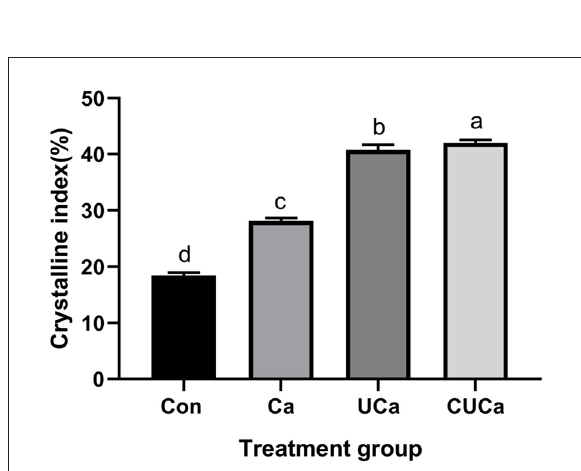
FIGURE2 Effect of CSL plus urea-alkali pretreatment on the cellulose crystalline index (CrI) of rice straw. Con: no pretreatment for control group, Ca: 4% CaO, UCa: 2.5% urea + 4% CaO, CUCa: 9% CSL + 2.5% urea + 4% CaO. Different superscript letters a,